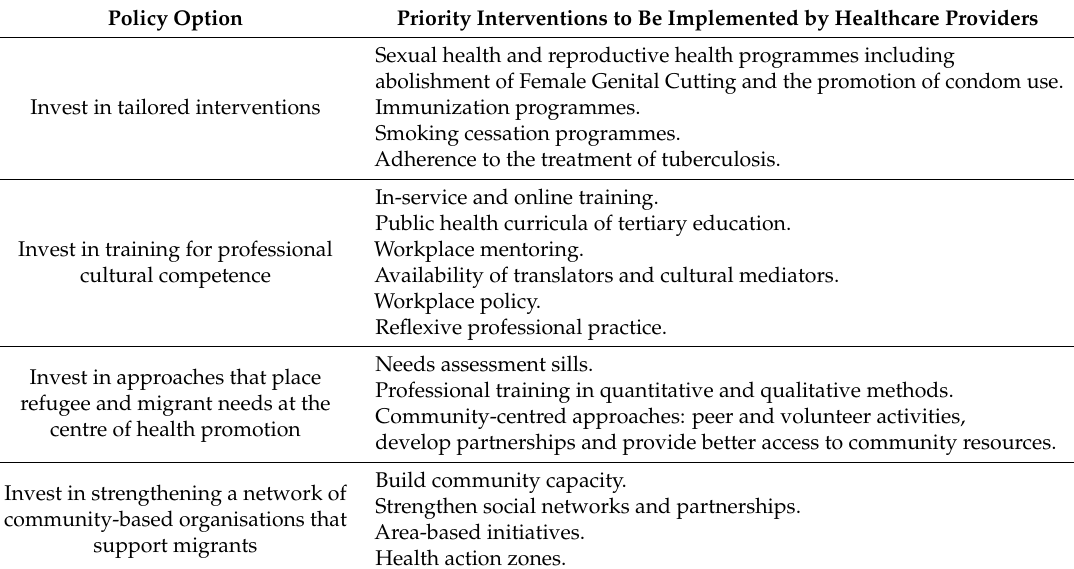
Table 1. Investing in refugee and migrant health